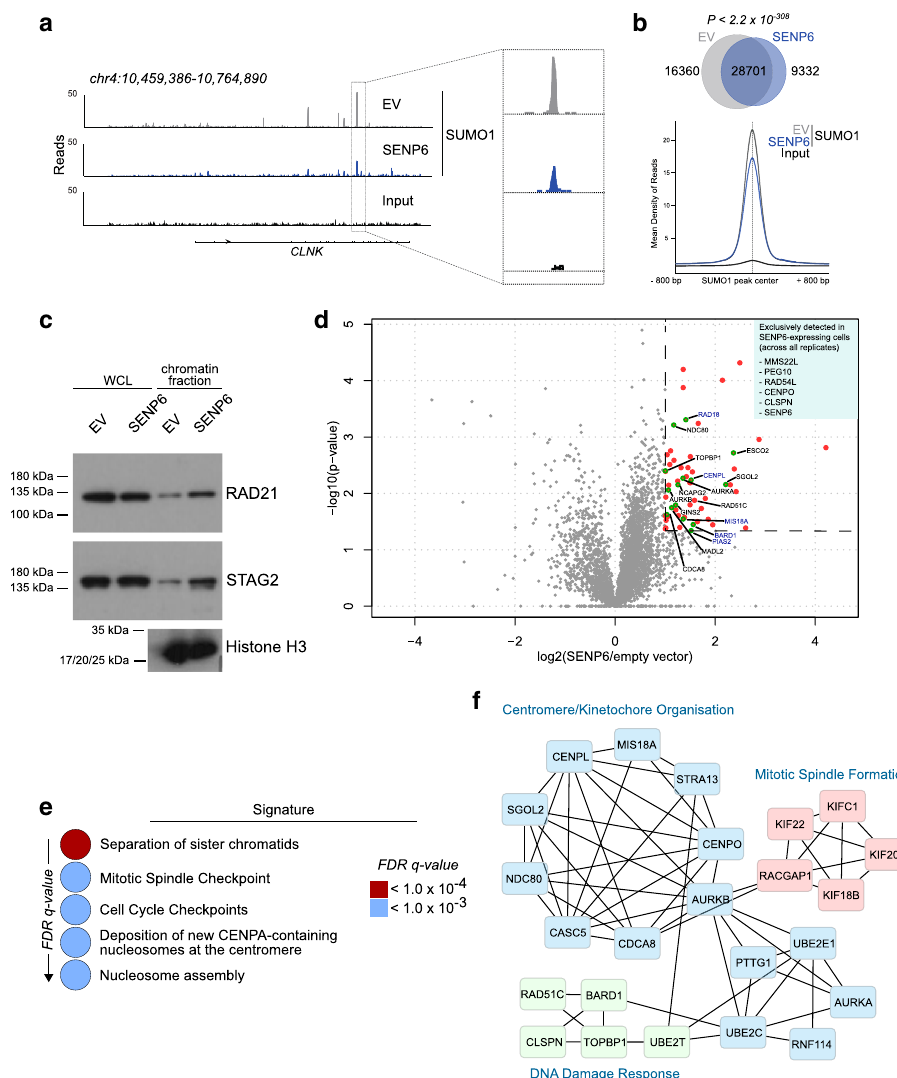
Fig. 6 SENP6 controls the SUMO/chromatin landscape in BCL. a Genome browser picture of read-normalized SUMO1 ChIPseq pro fi les from SU-DHL-5 cells with low SENP6 expression (EV, gray) or reconstituted for SENP6 expression (SENP6, blue) described in Fig. 3b. Input is shown in black. b Venn diagram (top) showing overlap of SUMO1 peaks in SU-DHL-5 cells with low SENP6 expression (EV, gray) or reconstituted for SENP6 expression (SENP6, blue) described in Fig. 3b. Density plot centered at 28701 common SUMO1 peaks (lower panel). Input is shown in black. P -value determined by hypergeometric test for enrichment in common peaks. c Immunoblot analysis of whole-cell lysate (WCL) and chromatin fraction of SU-DHL-5 EV and SENP6 cells with the indicated antibodies. Equal loading of WCL was controlled by Ponceau S staining. d Comparative MS results of chromatin fractionation in SU-DHL-5 EV and SU-DHL-5 SENP6 cells. Volcano plot depicting proteins exhibiting signi fi cantly reduced chromatin association SENP6 EV cells (absolute log2 ratio ≥ 1 and – log10 p > 1.3). High-con fi dence hits were determined using the Student ’ s t-test comparing LFQ values of SU-DHL-5 EV and SENP6 cells (two-tailed). Most enriched targets are shown here by plotting the negative log10 P -value against the log2 ratio of SU-DHL-5 SENP6/SU- DHL-5 EV. Signi fi cant hits are shown by red dots, bona fi de SENP6 targets are highlighted by green circles. Experiments were performed in triplicate. The inset on the right shows the six proteins that were found exclusively on chromatin in the SU-DHL-5 SENP6 cells in all three replicates. e Candidates from Fig. 6d were analyzed using the Reactome database. Color-coded FDR q -value is shown for the top fi ve enriched pathways. f STRING network analysis depicting the interconnection of proteins exhibiting reduced chromatin association in SU-DHL-5 EV cells when compared with SU-DHL-5 SENP6 cells. Only connected proteins are